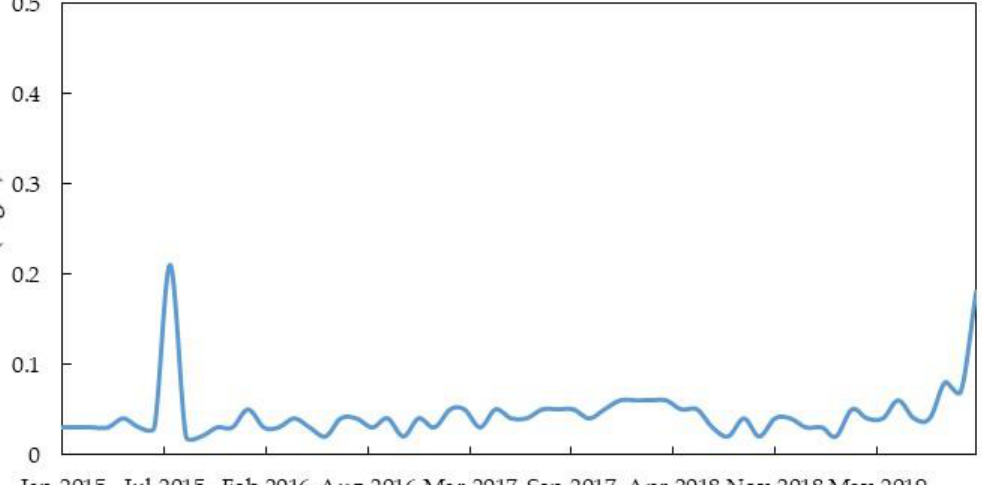
Figure 11. Annual TP concentrations in the Hongfenghu reservoir watershed from 2015 to 2019. Table 4. TN and TP loads in four towns in 2013 and 2017.